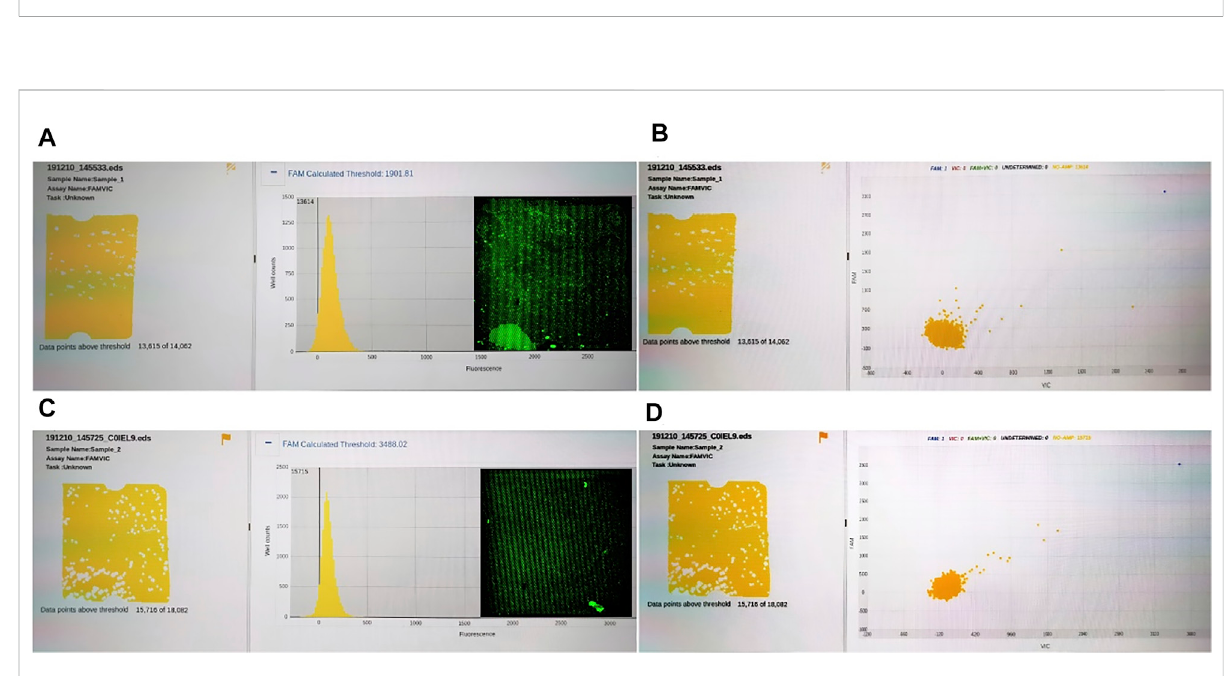
FIGURE 5 (A) Original image of UPE DNA with low concentration; (B) Image processed by software and the number of positive droplets with low- concentration DNA; (C) Statistics of all droplets containing UPE DNA with low concentration; (D) Original image of UPE DNA with high concentration; (E) Image processed by software and the number of positive droplets with high-concentration DNA; (F) Statistics of all droplets containing UPE DNA with high concentration.